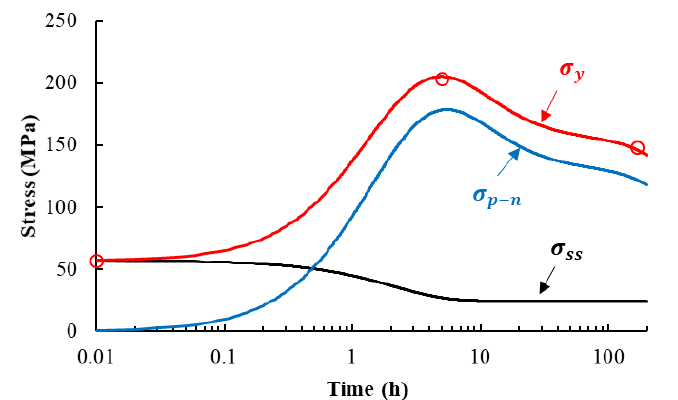
Figure 3. Comparison of evolutions of yield strength and corresponding strengthening components during artificial ageing of AA6063 at 185 °C from experiments (symbols [33]) and modelling results from Table 1 (lines).